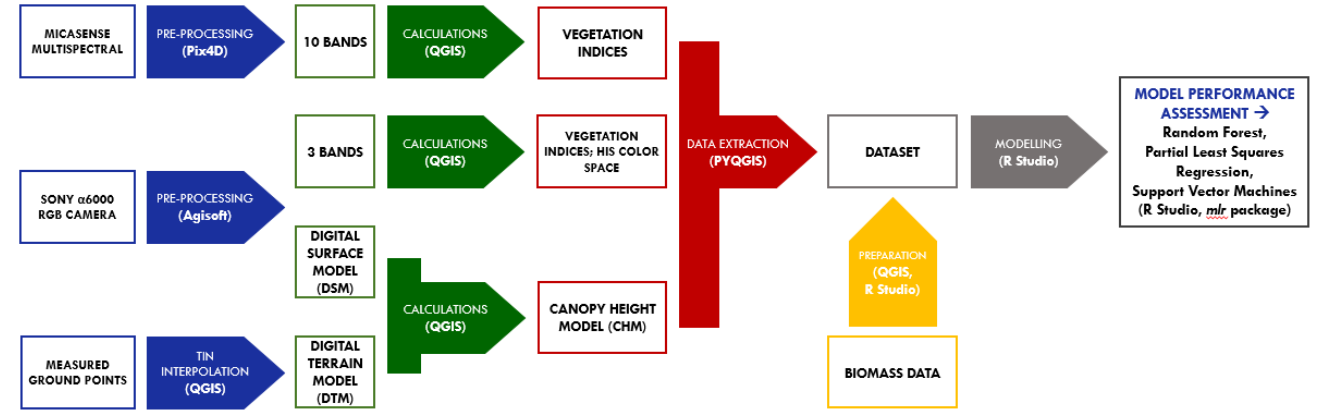
Figure 2. A schematic workflow illustrating the procedures of data collection, processing and modelling.